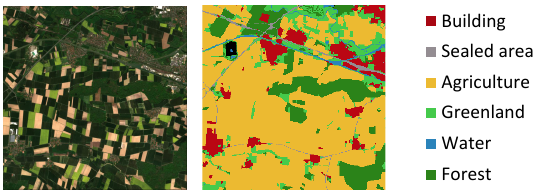
Figure 3. One Sentinel-2 image of size 8 × 8 km 2 (left) and corrected reference (middle) for dataset R 1